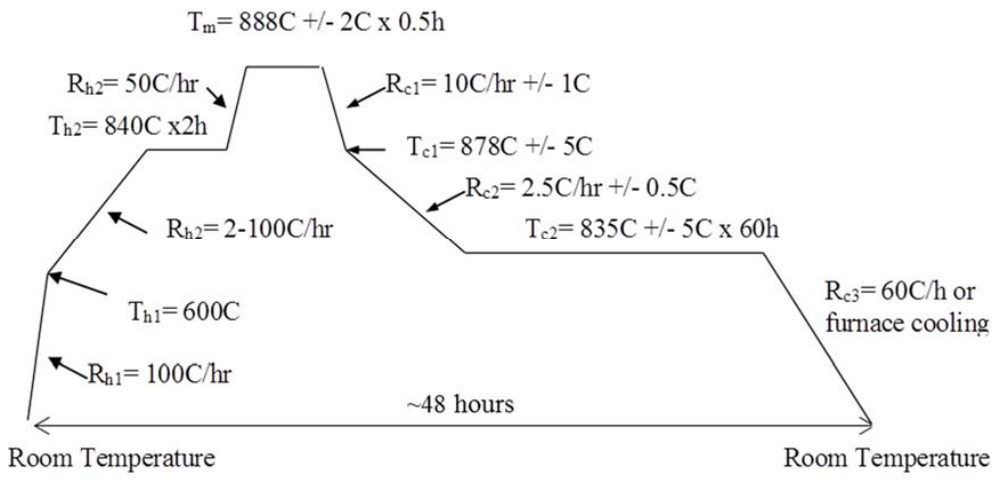
Figure 8. Bruker ‐ OST ‐ optimized heat treatment cycle for Bi2212 wire at 1 bar gas